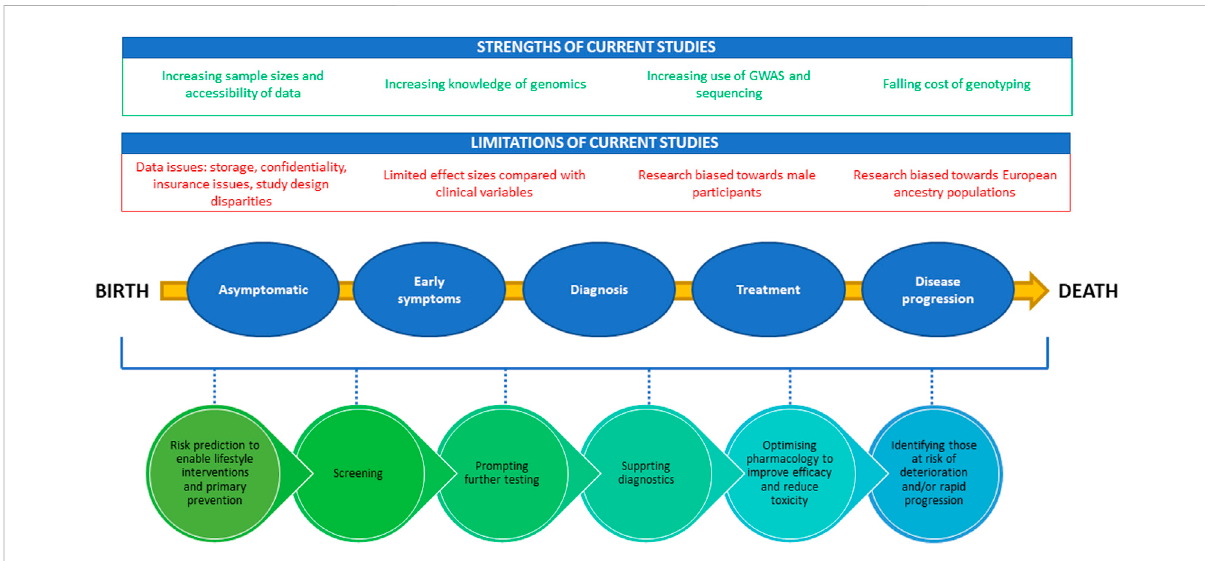
FIGURE 2 Adiagramdemonstratingpositiveandnegativefactorsin fl uencingPRSdevelopmentandthepotentialclinicalutilityofPRSsfrombirthtodeath. The strengths of the current studies are highlighted in green at the top of the fi gure, while limitations are shown in red. The bottom half of the fi gure provides the potential timepoints for utilization of PRSs through the life cycle from birth to